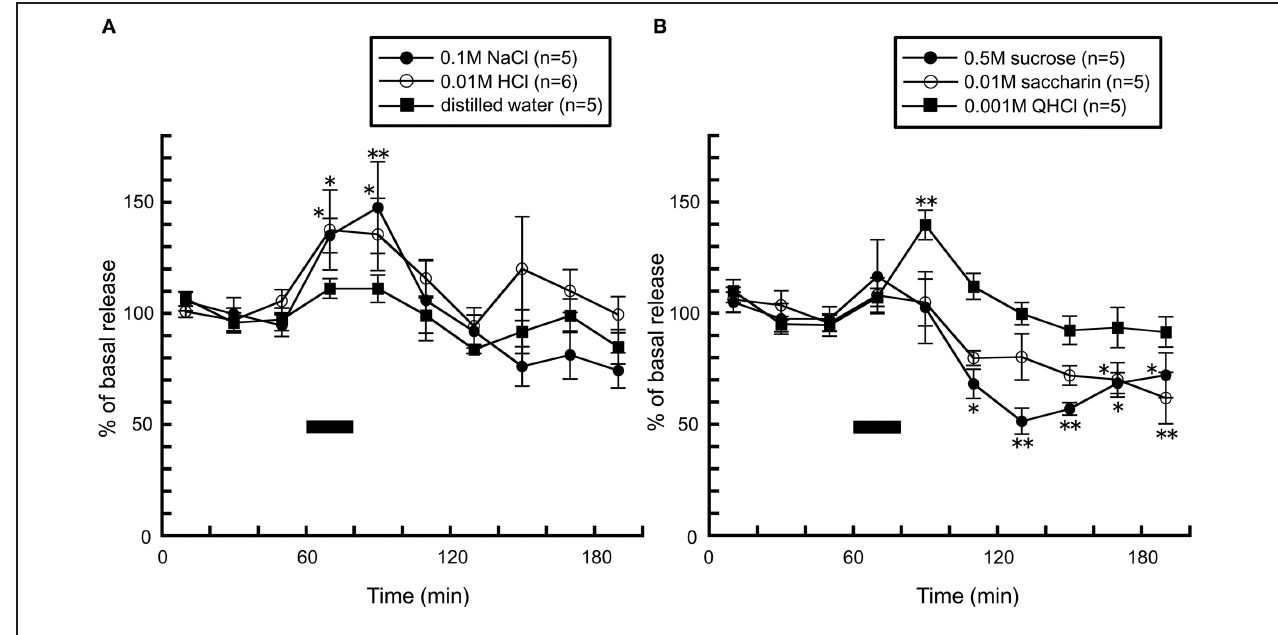
FIGURE 7 | The effect of (A) 0.1M NaCl ( n = 5), 0.01M HCl ( n = 6), and distilled water ( n = 5), and (B) 0.001M QHCl ( n = 5), 0.5M sucrose ( n = 5), and 0.01M saccharin ( n = 5) on the release of histamine in the anterior hypothalamus of freely moving rats [Treesukosol et al. (2005)]. The black bar indicates the 20min period